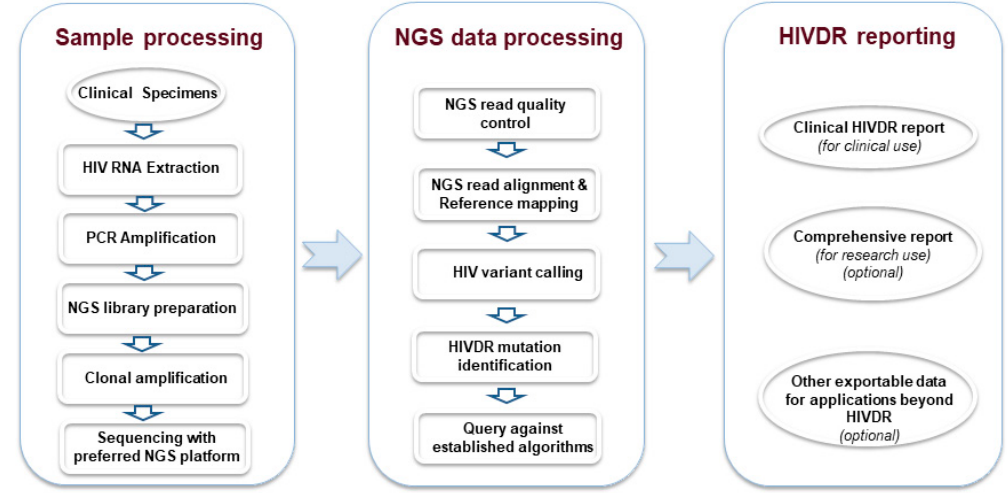
Figure 1. NGS-based HIV drug resistance testing workflow.